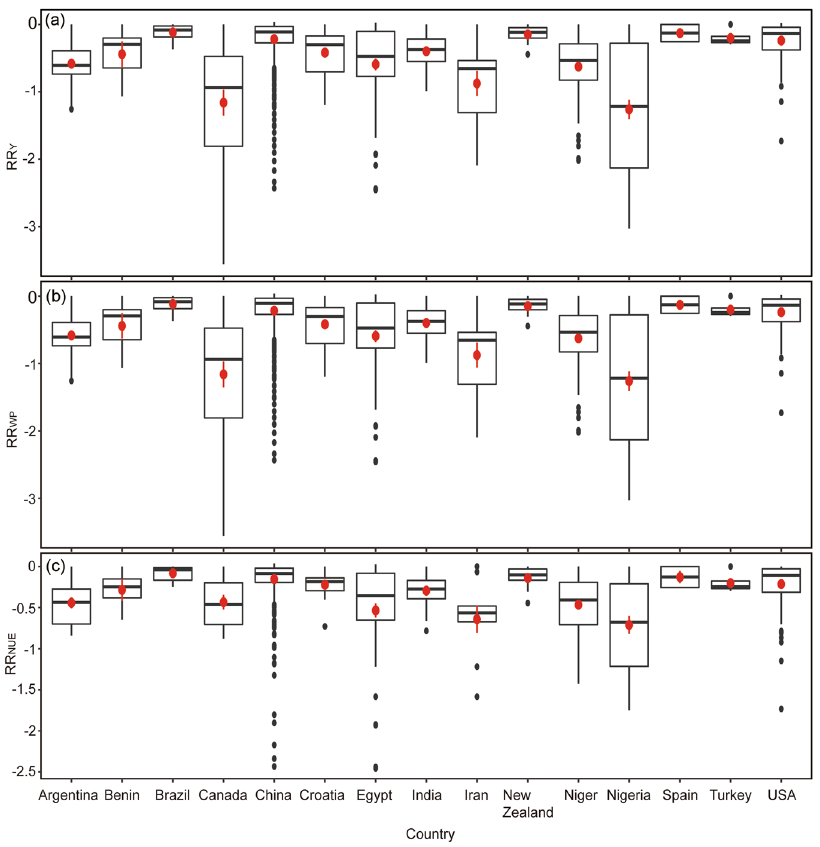
Figure 2. An overview of the response ratio of maize ( a ) yield ( RR Y ), ( b ) water productivity ( RR WP ), and ( c ) nitrogen use efficiency ( RR NUE ) over the main maize producing countries in the world. Response ratio stands for effect size between the treatment and control and is calculated using Eqs. 2–4. The horizontal line and the red dot (with standard deviation) indicate the median and average values; the limits of the boxes represent the 25 and 75 percentile (lower and upper limit, respectively); and vertical bars represent the 5 and 95 percentile. Note the different scales among the